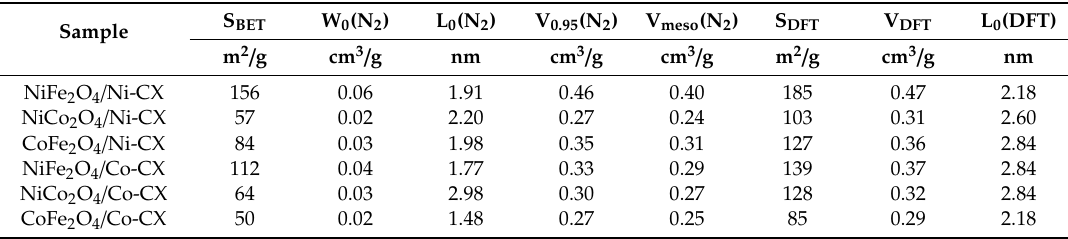
Table 1. Surface area